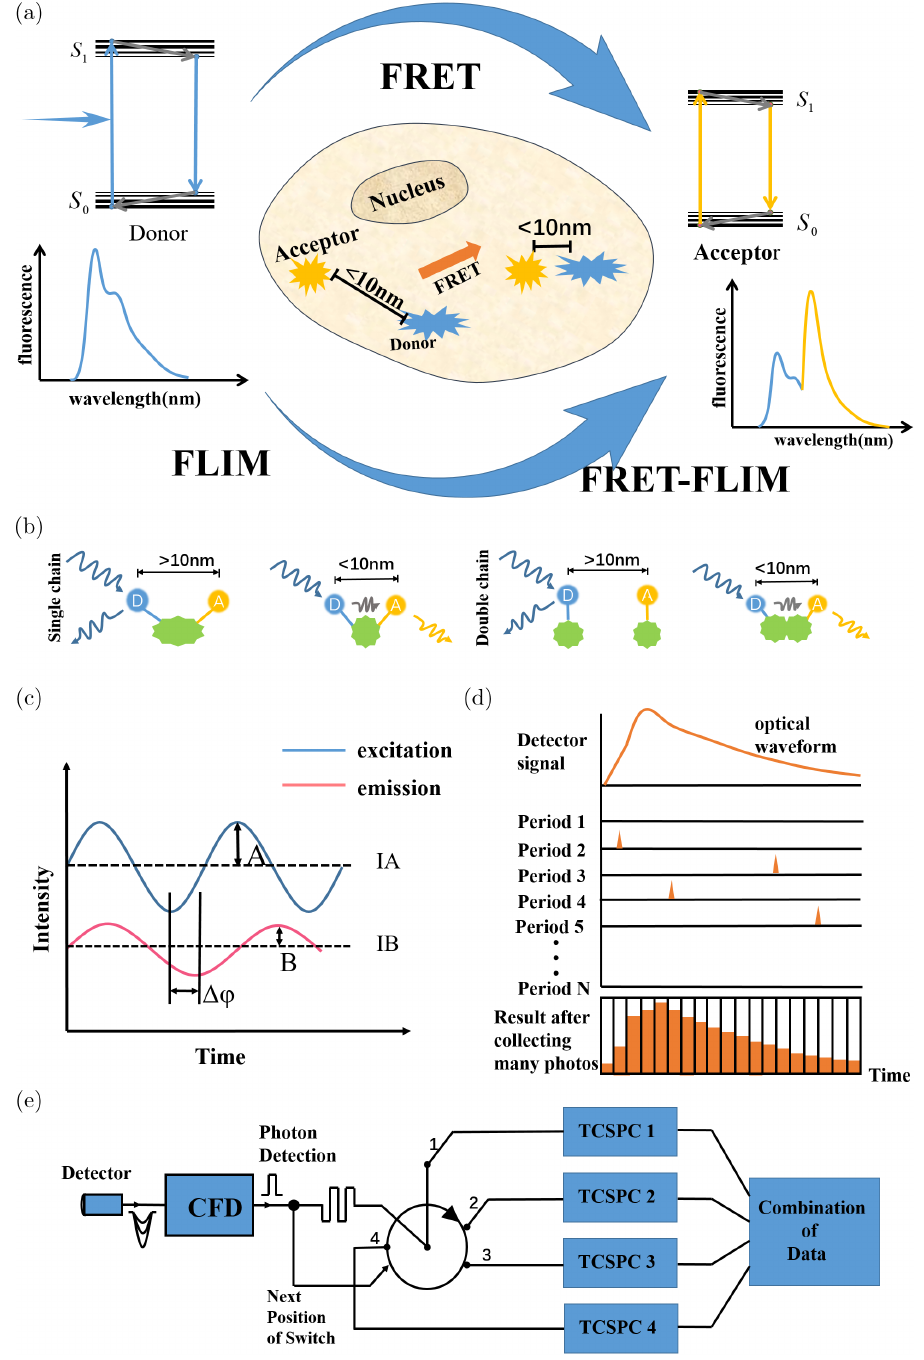
Fig. 1. FRET – FLIM e®ect generation principle, common structure and detection method. (a) FRET – FLIM generation schematic diagram; (b) FRET pairs' structure in FRET – FLIM technology; (c) Frequency domain principle diagram; (d) TCSPC schematic diagram; and (e) Fast-TCSPC circuit